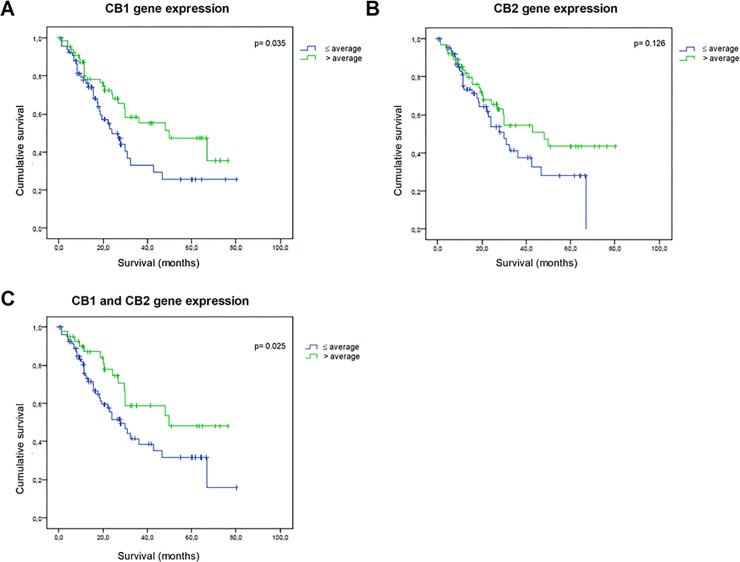
Cannabinoid receptors (CB1 and CB2) expression in 157 patients with non-small cell lung cancer (NSCLC).Analysis of the survival of patients with NSCLC according to whether their CB1 (A), CB2 (B), or CB1/CB2 (C) ΔCt values were higher or lower than the mean ΔCt value of the entire cohort.